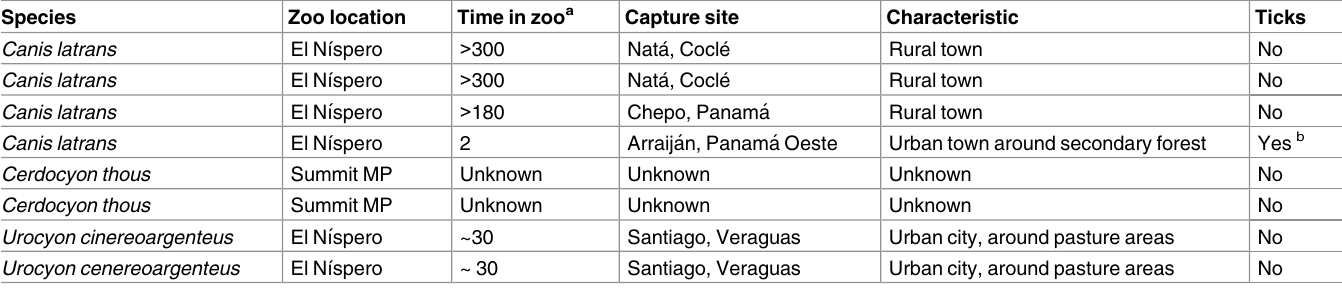
Table 1. Sites where wild canids were originally captured.